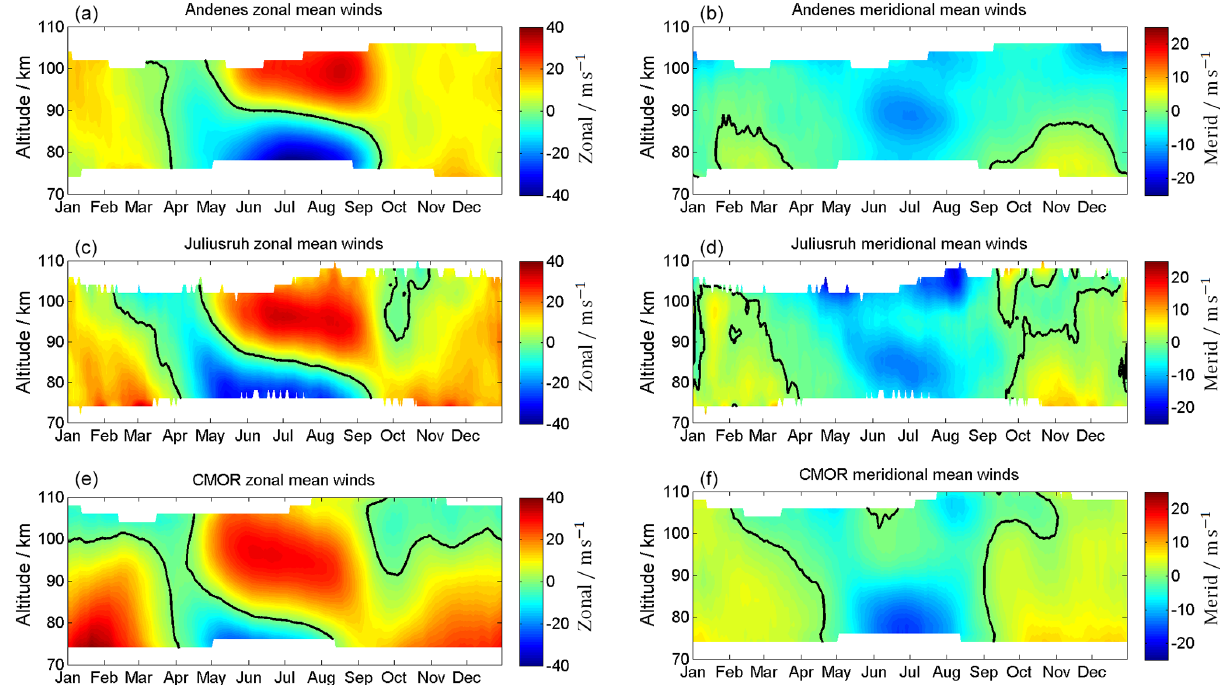
Figure 2. Composite of zonal (a, c, e) and meridional (b, d, f) wind components for Andenes (a, b) , Juliusruh (c, d) , and CMOR (e, f) . The black line corresponds to the wind reversal. Note the different labels of the color